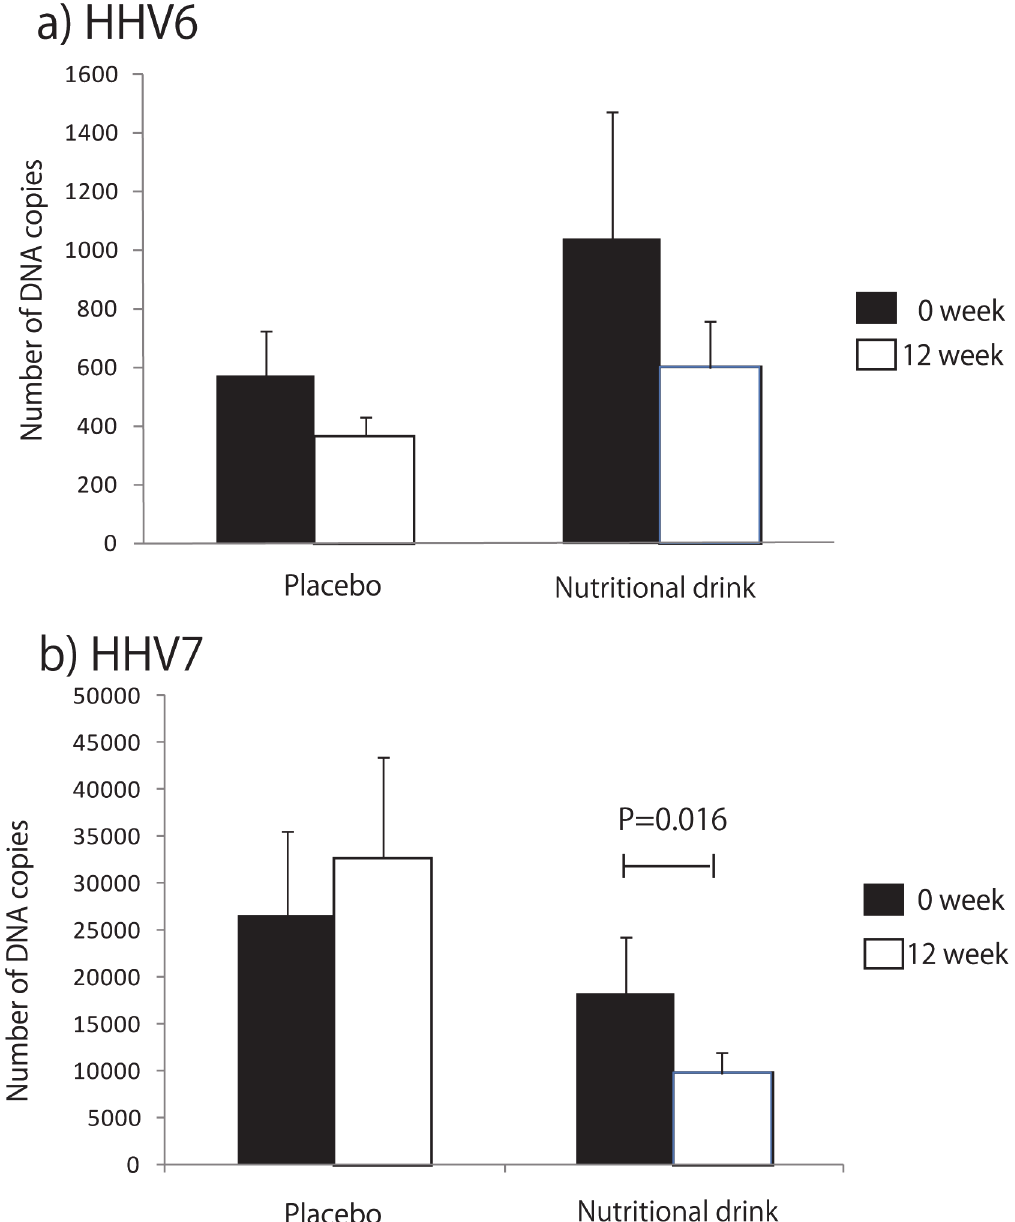
Fig 3. Changes in HHV6 and 7 reactivation following nutritional supplementation in patients with ESRD (0 – 12 weeks). Differences of changes in the number of copies of (a) HHV6 and (b) HHV7 DNA were determined via the Mann – Whitney test by treatment groups, placebo and nutritional drink (HHV6, Z = − 6.08, P = 0.54 and Z = − 0.18, P = 0.86 and HHV7, Z = − 0.62, P = 0.54 and Z = − 2.43, P = 0.016, respectively). We performed the statistical analysis for the samples that exceeded the detection limits, thereafter, the number of participants with these parameters were smaller than in the total samples (HHV6, 23 in the placebo and 22 in the nutritional drink groups, and HHV7, 50 in the placebo and 60 in the nutritional drink groups). Error bars represent the standard error of the